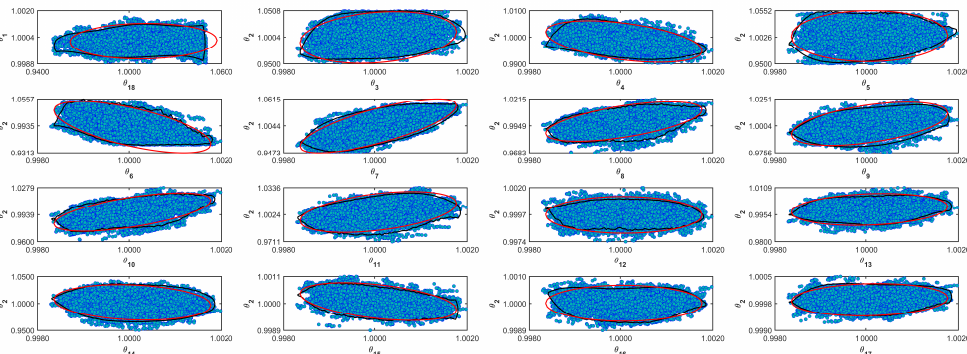
Figure A2. Coverage regions of parameters 02: (—) Gaussian region; (—) Possolo [33]